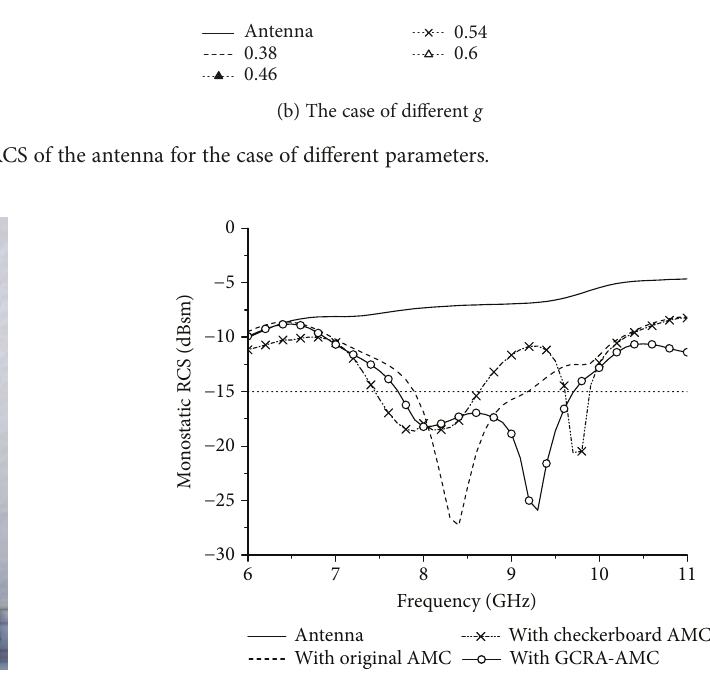
Figure 6: The con fi guration of the checkerboard AMC.